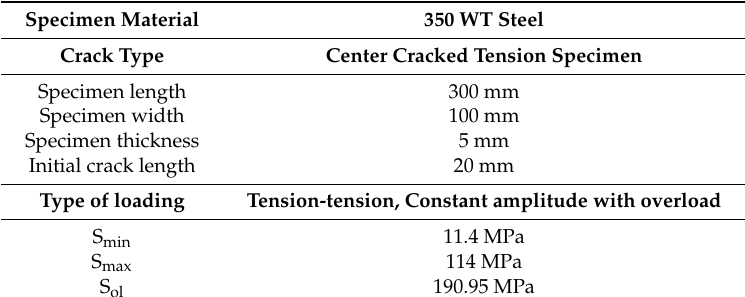
Table 10. The experimental information of 350 WT steel.